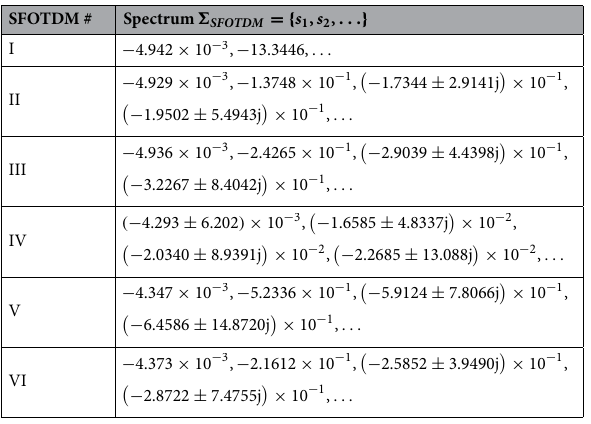
Table 4. Dominant pole SFOTDMs